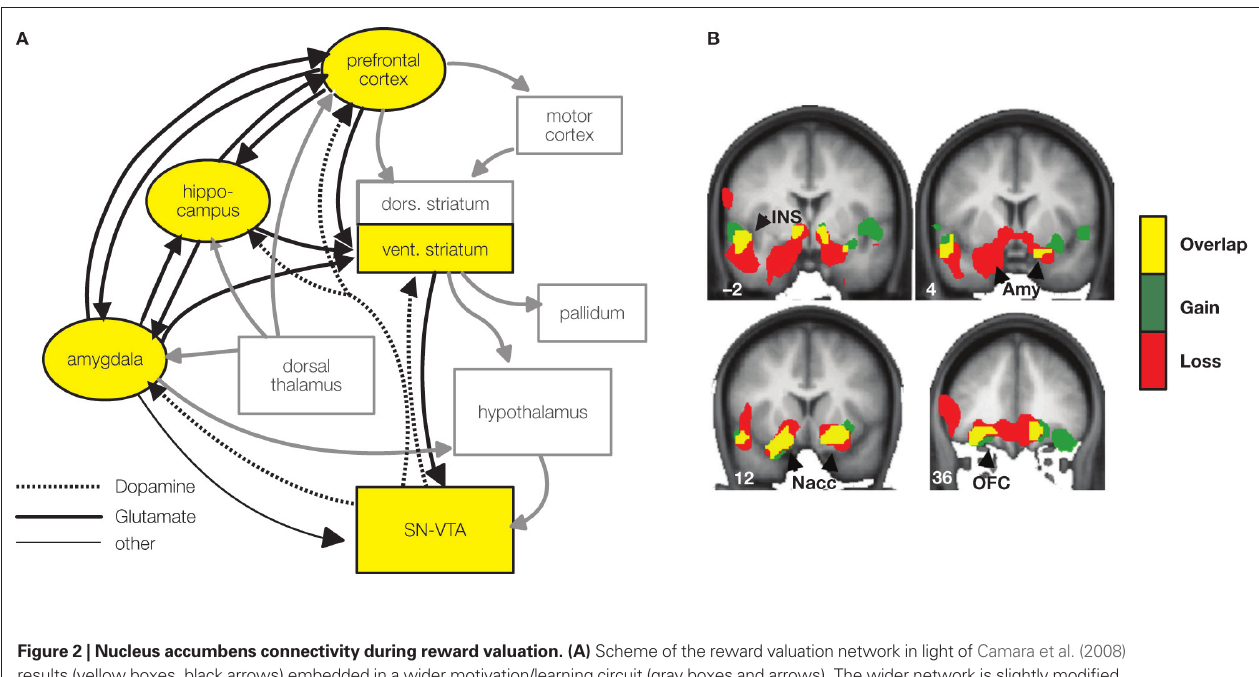
Figure 2 | Nucleus accumbens connectivity during reward valuation. (A) Scheme of the reward valuation network in light of Camara et al. (2008) results (yellow boxes, black arrows) embedded in a wider motivation/learning circuit (gray boxes and arrows). The wider network is slightly modified (omitting unspecific hypothalamic/thalamic projections) from Kelley (2004). (B) Regions functionally connected with the nucleus accumbens (NAcc) after unexpectedly large sums were won or lost are superimposed on a group-averaged structural MRI image in standard stereotactic space ( T -score overlays). Gains and losses connectivity patterns are simultaneously depicted: gain (green, P < 0.001), loss (red, P < 0.001) and conjunction gain ∩ loss (yellow, P < 0.001 and P <